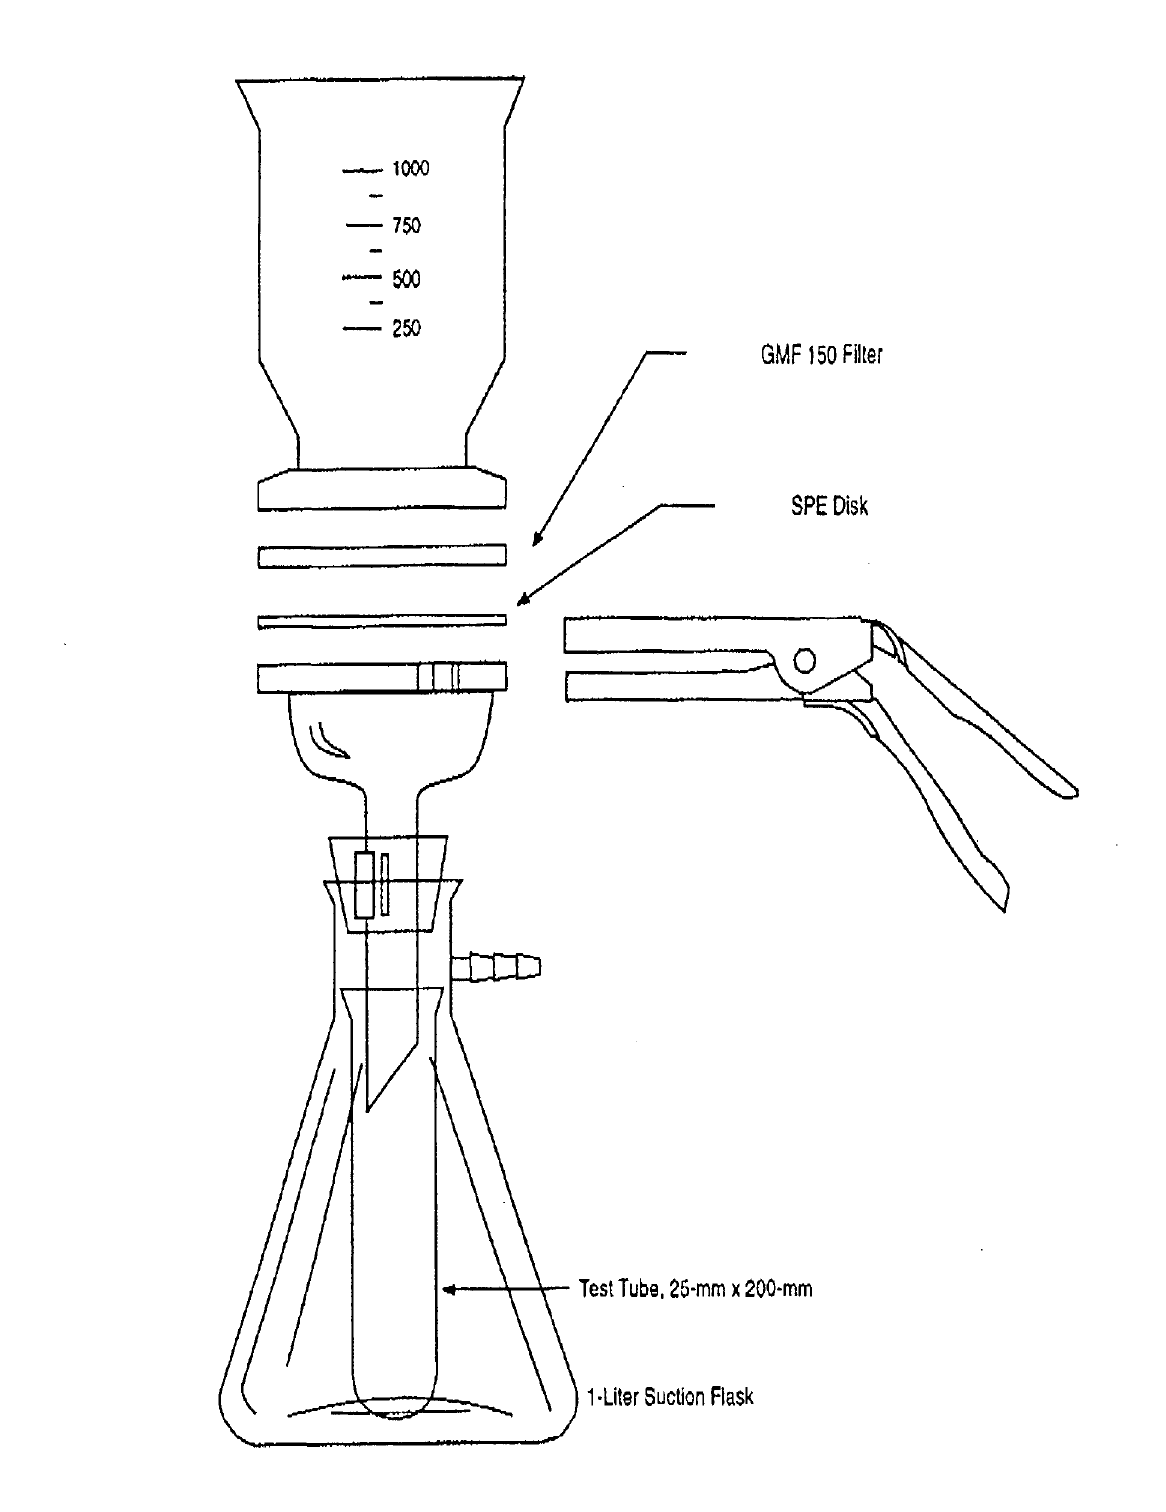
Solid-phase Extraction